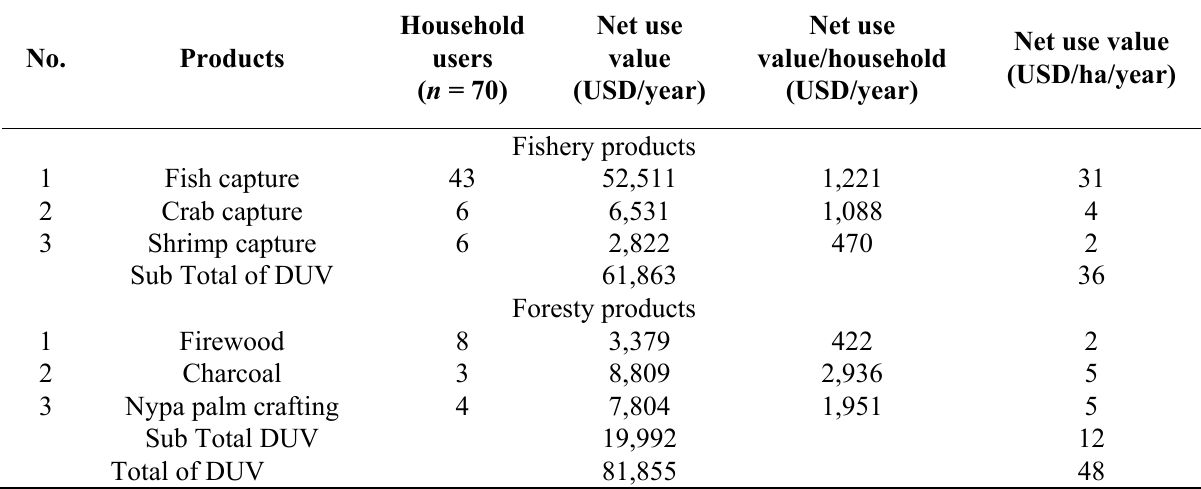
Table 1. The Direct Use Value (DUV) of mangrove in the Takalar district, South Sulawesi,